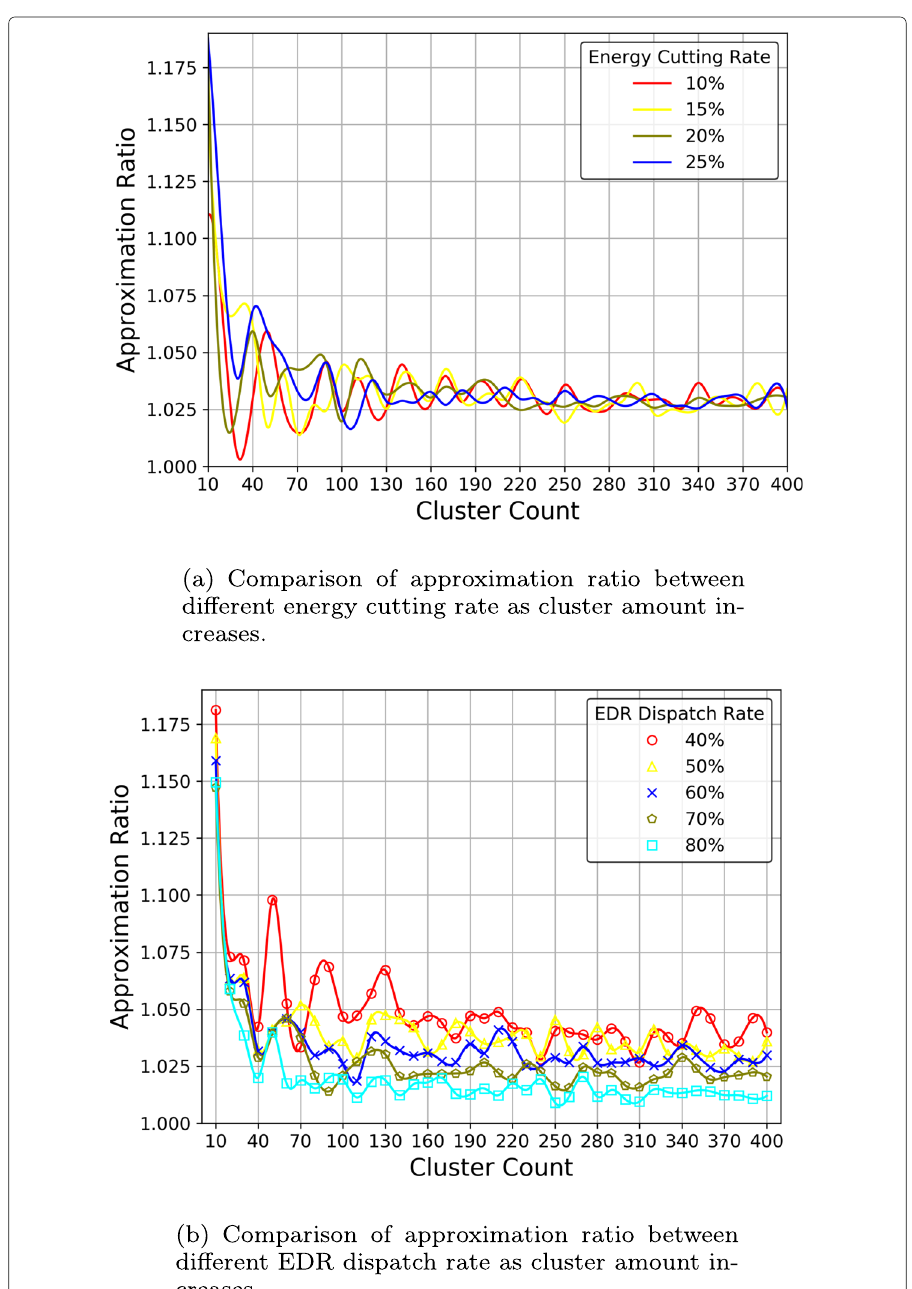
Fig. 3 Performance evaluation on